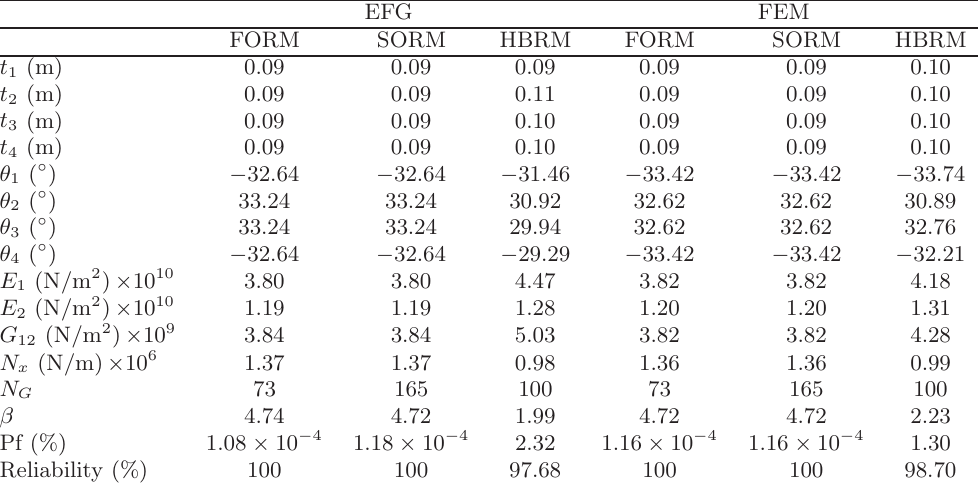
Table 7. Reliability analysis results, case